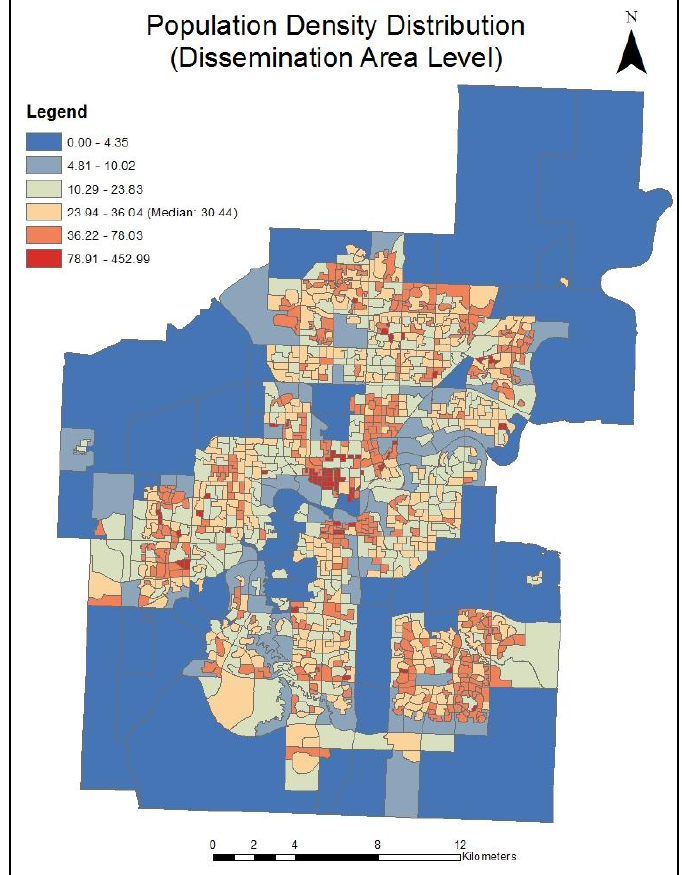
Figure 6. Population density distribution at dissemination area level. Note: Dissemination Area (DA) Level is defined as the smallest standard geographic area for which all census data are disseminated, typically with a population of 400 to 700 persons (Statistics Canada,